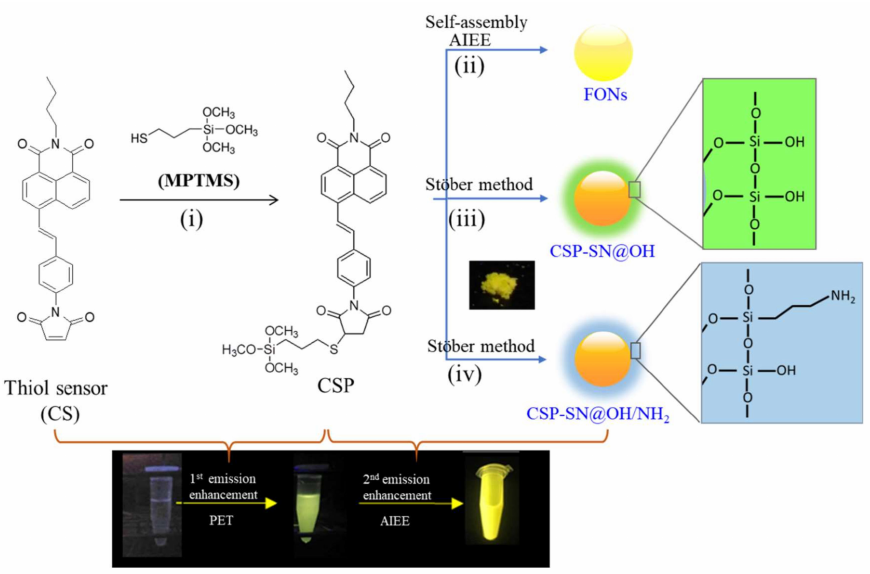
Figure 1. Synthesis of CSP and illustration of fluorescent organic nanoparticles (FONs), CSP-doped silica nanoparticles with a TEOS hydrolysis shell (CSP-NP@OH) and CSP-doped silica nanoparticles with a TEOS / APTMS mixed hydrolysis shell (CSP-NP@OH / NH 2 ). (i) MPTMS, rt, 1 h; (ii) THF / H 2 O mixed solvent; (iii) TEOS, C 2 H 5 OH, NH 4 OH; (iv) TEOS, APTMS, C 2 H 5 OH, NH 4